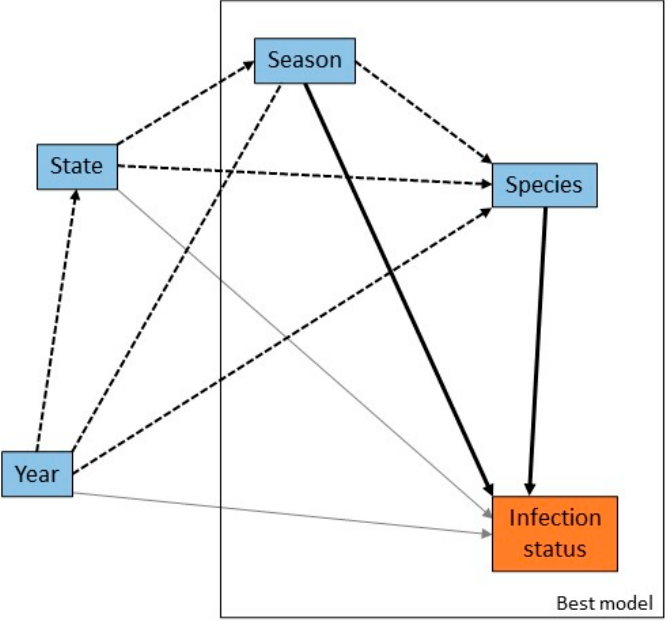
Figure 3. Causal web of association between infection risk factors and ABLV infection status. Heavy black arrows are significant univariable associations between the risk factors and infection status, dotted arrows are significant associations between pairs of risk factors, and grey arrows are plausible causal associations that were not statistically significant in our dataset. The rectangle encloses the suite of variables that produced the best multivariable model.